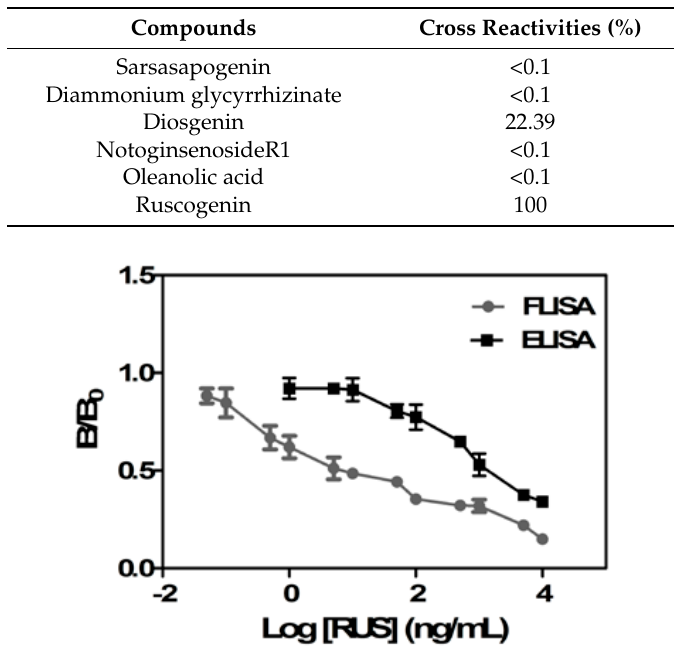
Figure 4. The inhibition curves for the determination of RUS by indirect competitive ELISA and FLISA.